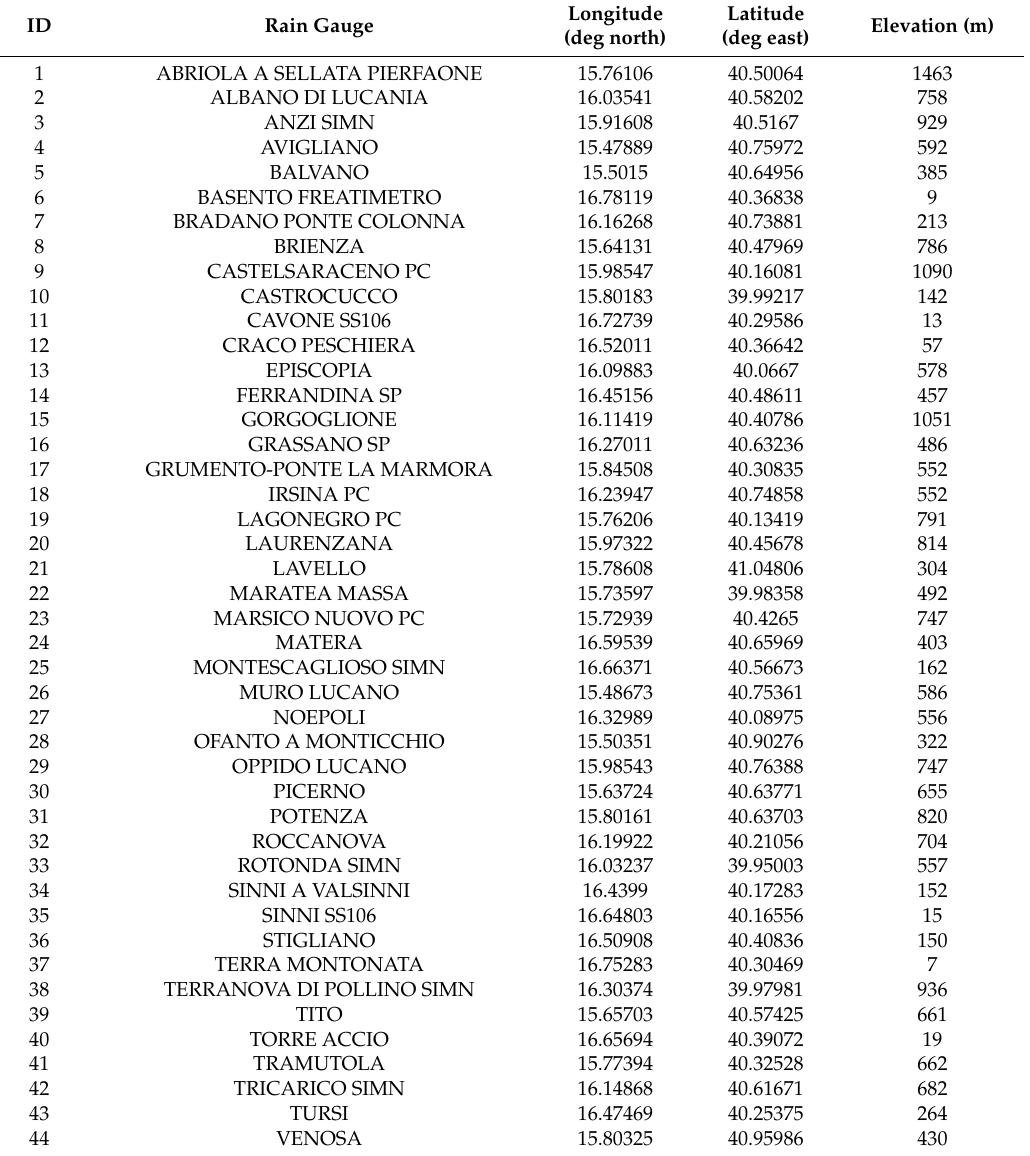
Table A1. Identity code (ID), location and altitude of ground observation